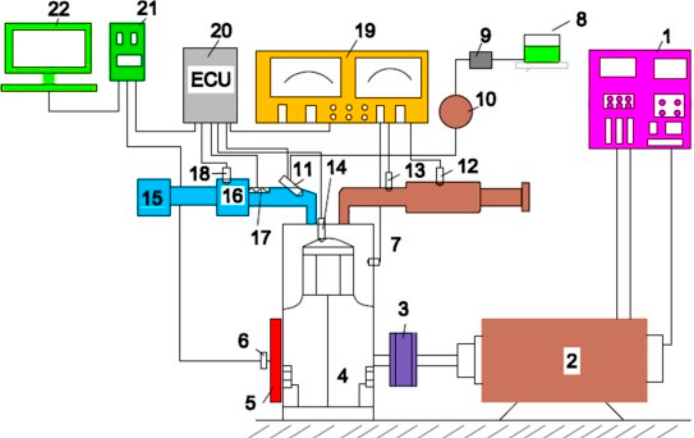
Figure 1. The structure of the experiment setup.